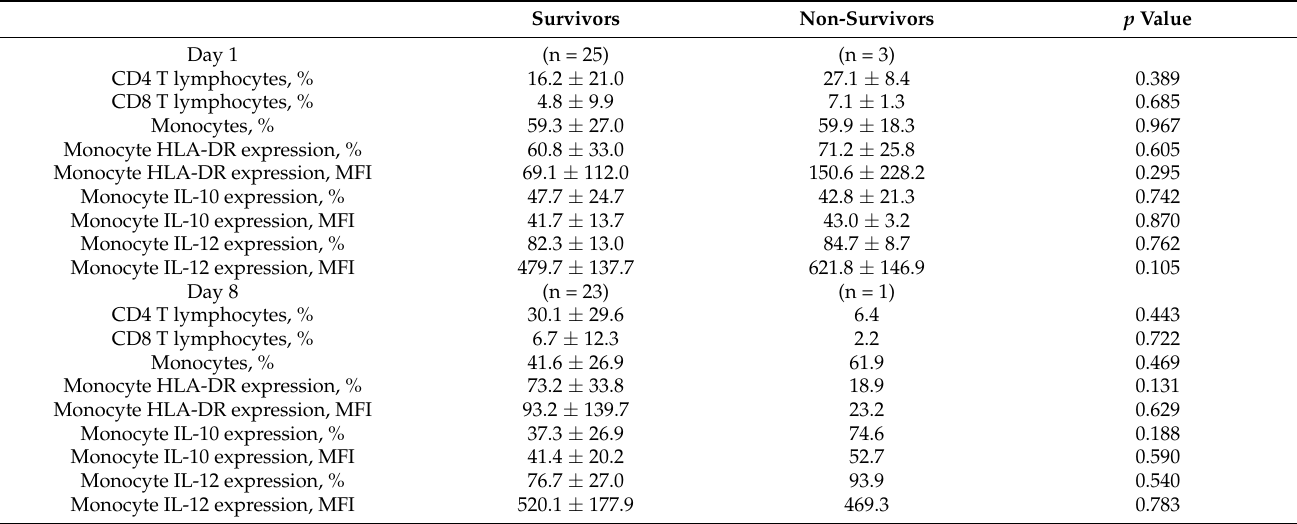
Table 2. BAL mononuclear cells in patients with ARDS (mean ± standard